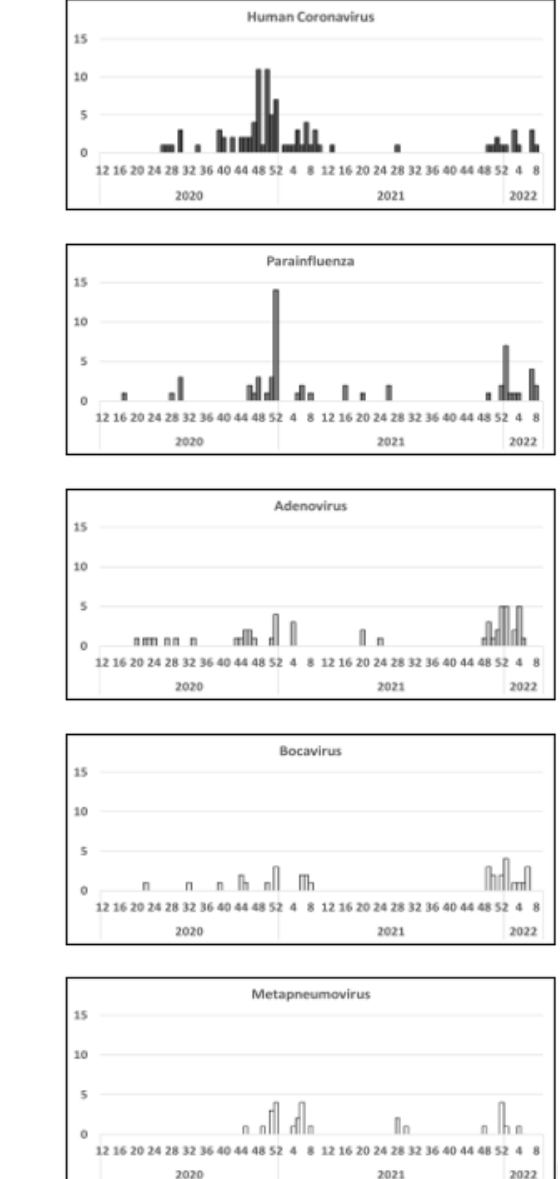
Figure 2. Weekly distribution of respiratory viruses detected in samples from COVID-19-negative patients, March 2020 to February 2022, Madagascar. For comparison, the circulation profile of SARS-CoV-2 during the same period is shown.